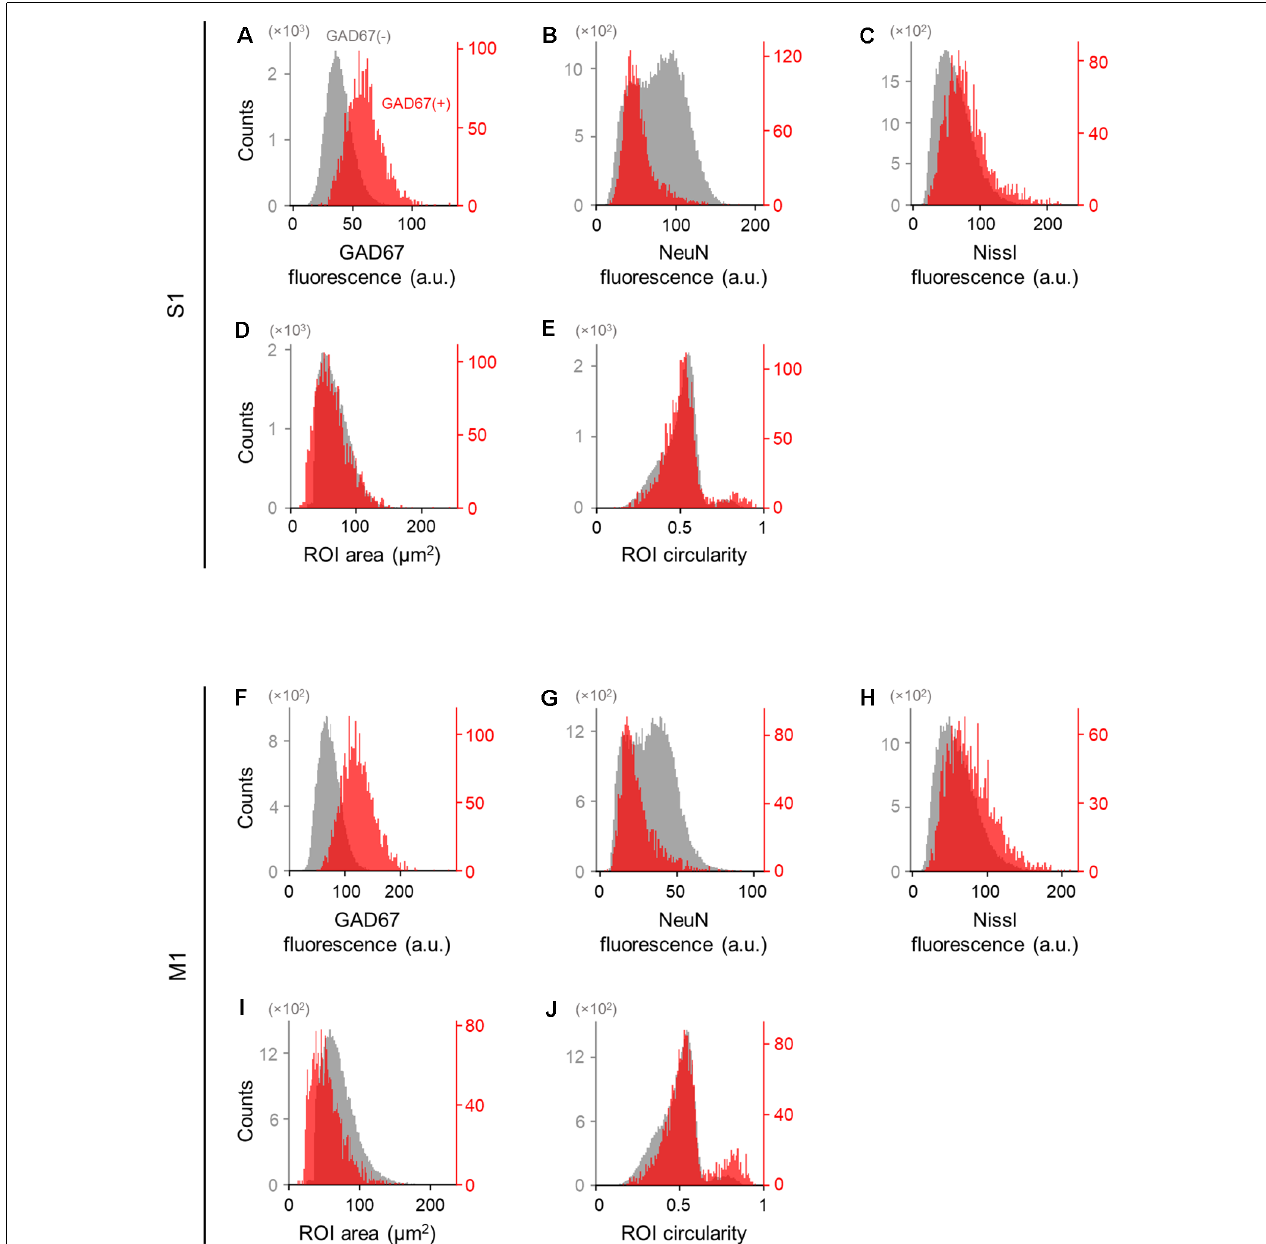
FIGURE 3 | Differences in the immunofluorescence and shape of GAD67-positive and GAD67-negative cells in the primary somatosensory and motor cortices. (A) Histogram of the fluorescence of anti-GAD67 signals of manually annotated GAD67-positive (red) and -negative (gray) neurons in S1. (B) The same as (A) , but for anti-NeuN immunofluorescence signals. (C) The same as (A) , but for Nissl fluorescence signals. (D) The same as (A) , but for the area of individual neurons (i.e., ROIs). (E) The same as (A) , but for the circularity of individual neurons (i.e., ROIs). (F–J) The same as (A–E) , respectively, but for M1. Abbreviations: S1, primary somatosensory cortex; M1, primary motor cortex; ROI, region of